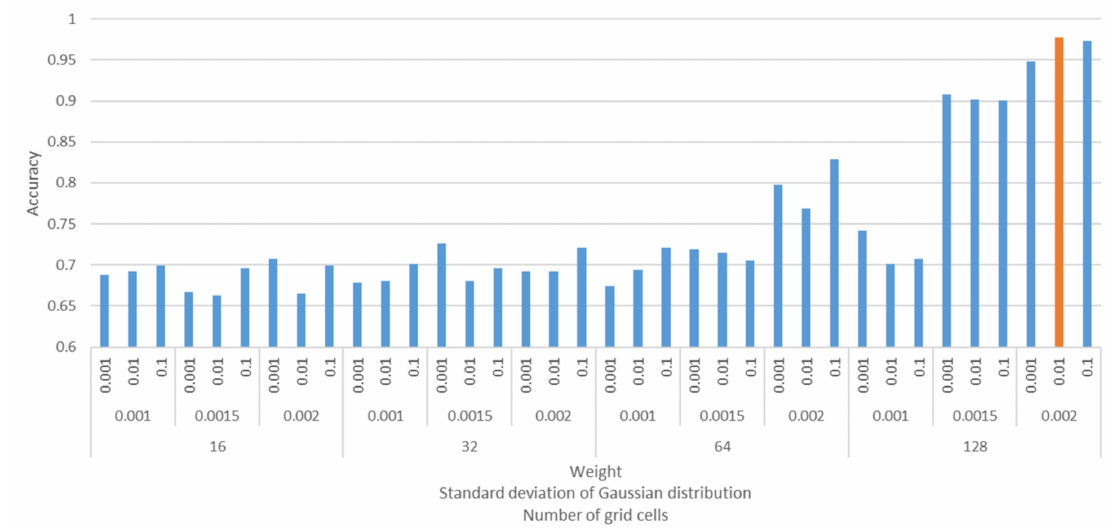
Figure 7. Prediction accuracies of the validation data with different combinations of parameters. The accuracy was defined as the ratio of the number of morphologies that predicted the correct class to the number of validation data instances. The top row in the horizontal axis is the weight on the persistence surface β ; the middle row is the standard deviation of the Gaussian distribution h ; and the bottom row is the number of subdomains g . The orange bar represents the combination of parameters that produces the highest accuracy.